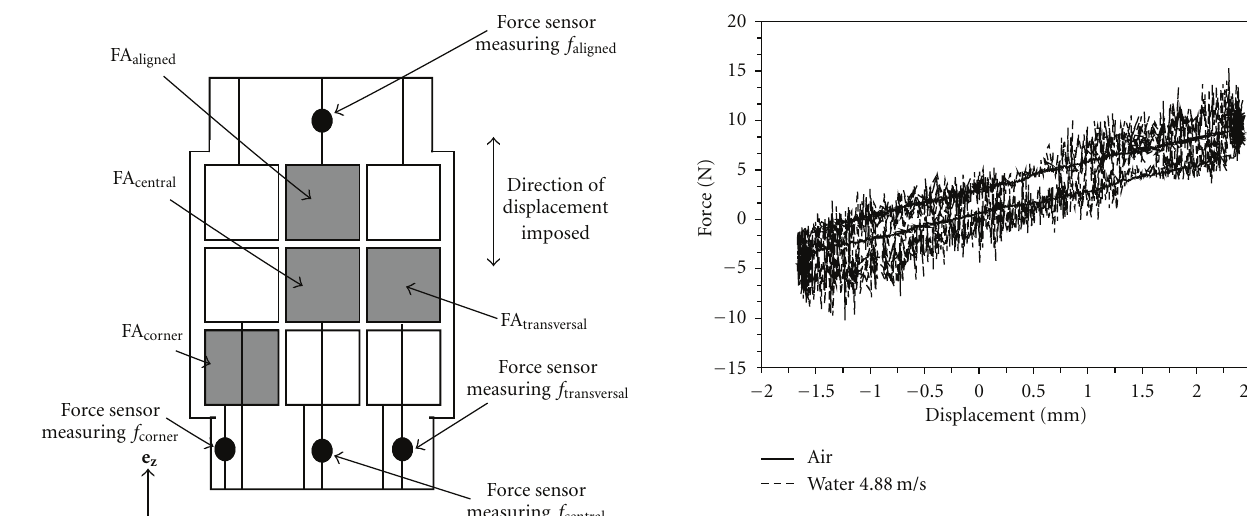
Figure 6: Force measured by the sensor 4 versus the hydraulic jack displacement, quasistatic